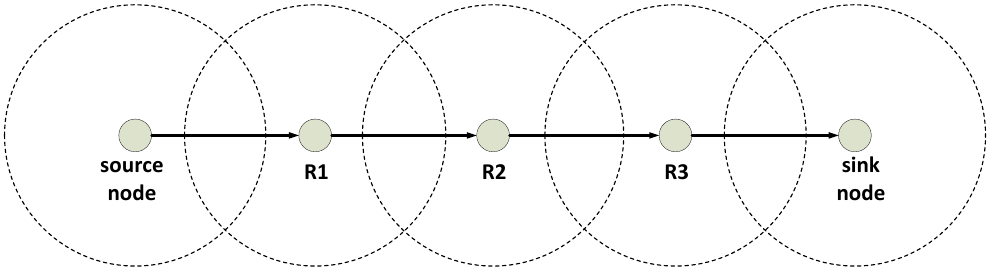
Figure 6. Linear chain topology of five nodes. Source + 3 relays + sink. Table 4. Simulation